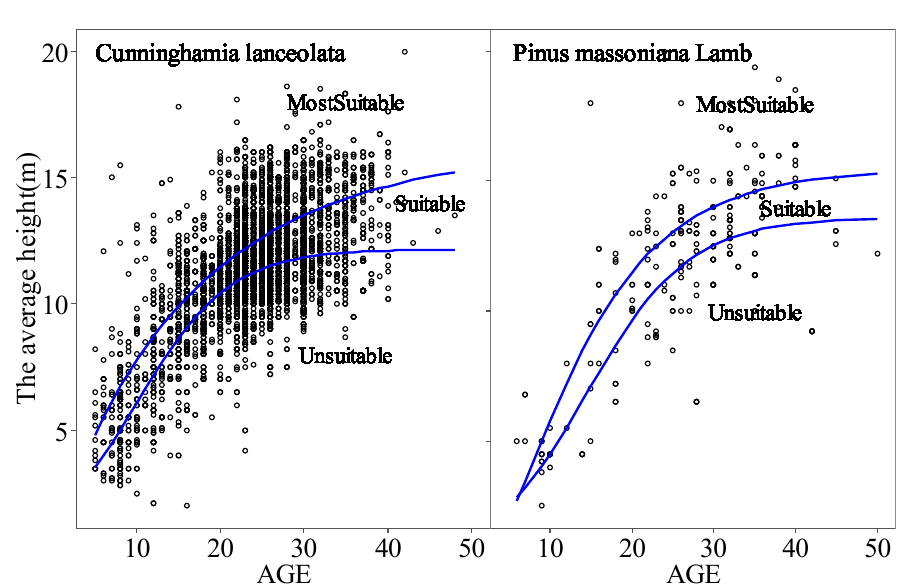
Figure 3. Distribution of stand site tree suitability of Chinese fir and Masson Pine.